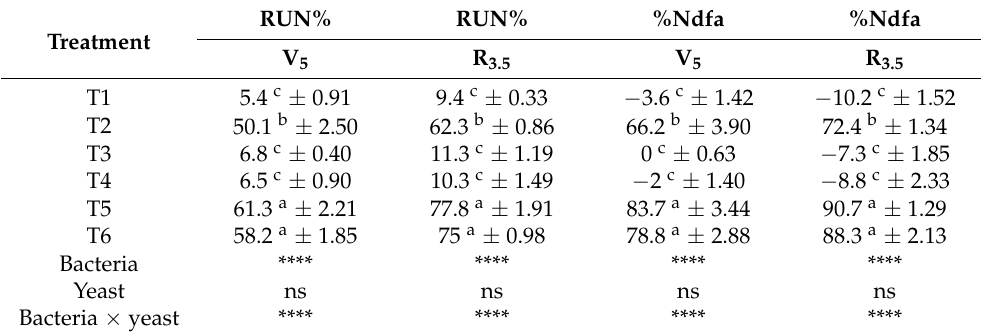
Table 2. Differences in relative ureide-N (%) (RUN %) and percentage of N derived from the atmosphere (%Ndfa), at V 5 and R 3.5 physiological stages across treatments.